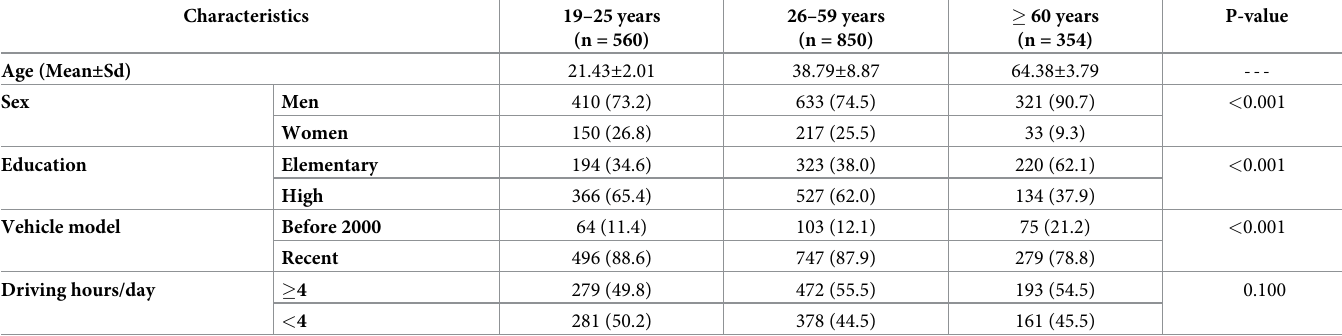
Table 1. Sociodemographic characteristics of non-professional drivers distributed by age category. Characteristics